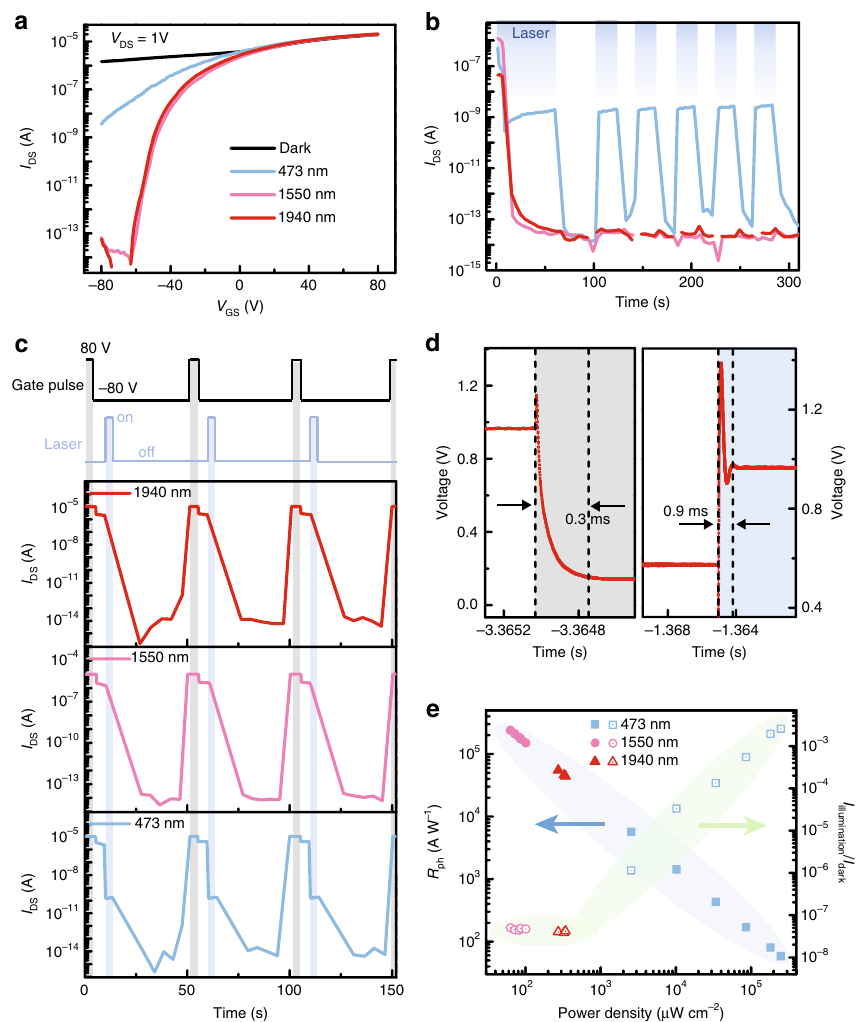
Fig. 3 Photoresponse properties of the device. a I DS – V GS curves of the device under dark and illuminated states with 473 nm (248 mW cm − 2 ), 1550 nm (100.6 μ W cm − 2 ) and 1940 nm (327.1 μ W cm − 2 ) lasers. V DS = 1 V, T = 80 K. b Time-resolved photoresponse measurement at V GS = − 80 V. The fi gure legend is same as ( a ). The blue rectangle represents the illuminated state. c Multiple electro- and photo-excitation cycles with the gate voltage pulses ( + 80 V, 8 s) and laser pulses (5 s). d Response time of the electro- (left panel) and photo-excitation (right panel) process. The laser wavelength is 1550 nm. e The corresponding photoresponsivity ( R ph ) and I illmination / I dark ratios as a function of power density at V GS = − 80 V. Source data are provided